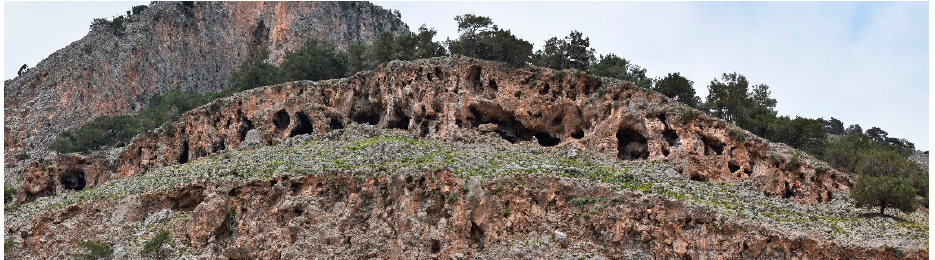
Figure 10. Extensive karst features predominantly observed in the southern part of Samaria